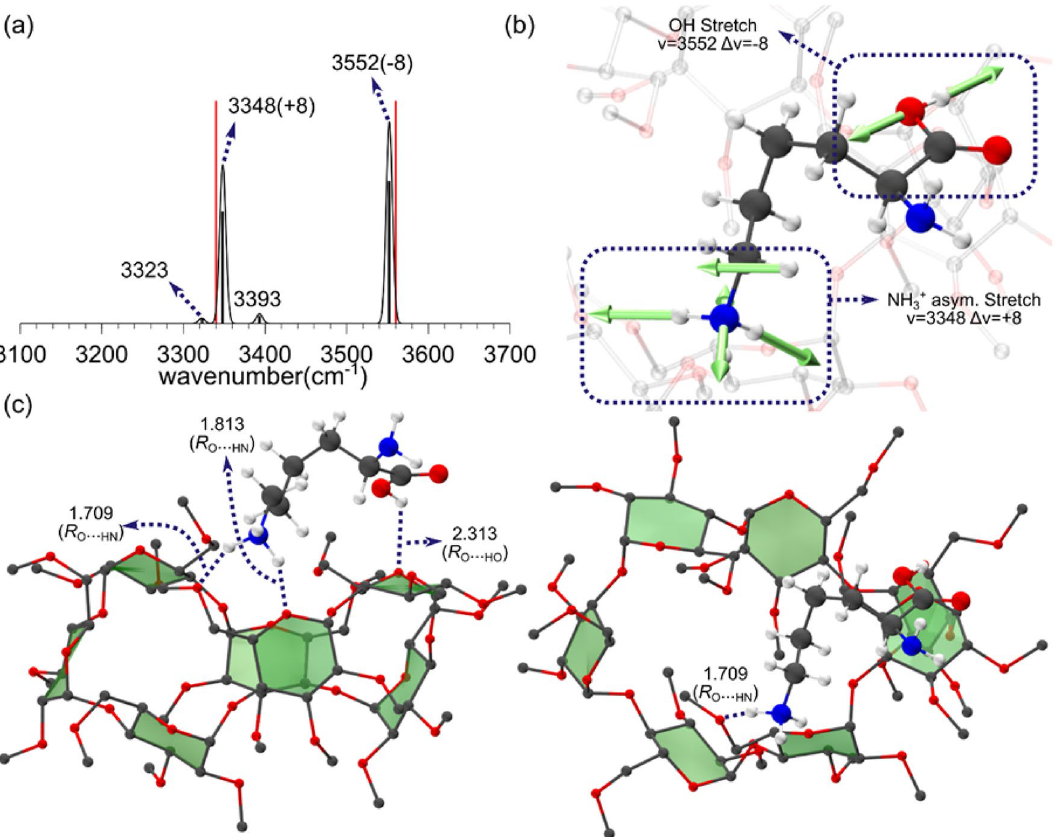
Figure 1. ( a ) Theoretical IR spectrum, ( b ) normal modes, and ( c ) two views of the structure of Complex I of gas phase perm β-CD–protonated L-Lys. Red sticks represent the positions of experimental IRMPD bands. Hydrogen atoms in permetylated β -cyclodextrin are omitted for clarity. Red: oxygen, blue: nitrogen, gray: carbon, white: